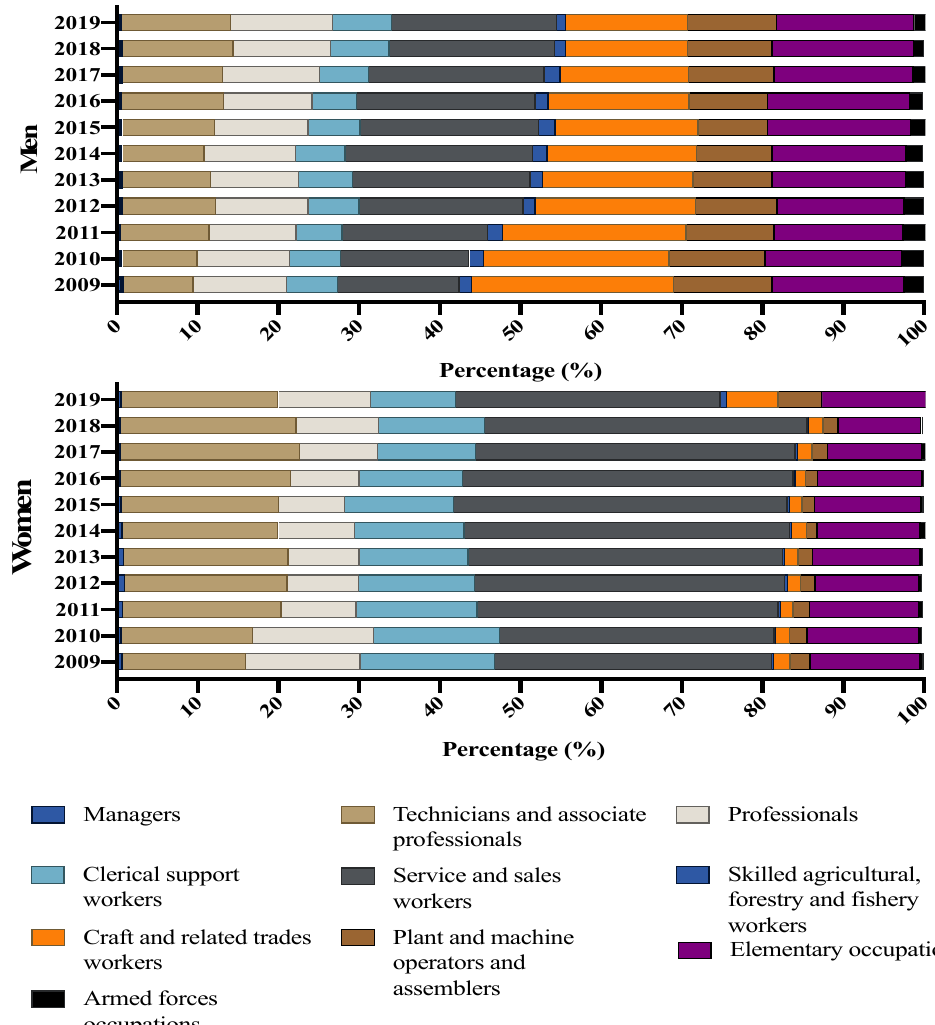
Figure 7. Employed people under 30 by gender and occupation, 2008–2019. Source: Eurostat. The pandemic that hit the world in 2020 caused the situation of dependency and insecurity for young people to worsen in the case of Spain. During the first semester of 2020, the number of contracts signed by people under 30 decreased more than those signed by the rest of the population. It is worth keeping in mind that this period included the economic standstill caused by the pandemic. According to PES data, temporary hiring of people under 30 between January and June 2020, in comparison to the same period in 2019, was reduced by 35.3% in the male population and 42.5% in the female population, and temporary hiring of people over 30 decreased by 30.3% and 39.9%, respectively. Regarding permanent hiring, the reduction in the same period was lower: 32% and 3.5% compared to 27.4% and 27.4%, respectively. Women under 30 lost the most contracts during this health crisis period, mainly in the service sector, one of the worst hit by the crisis. Figure 8 shows the evolution between 2019 and the second semester of 2020 of unemployment rates, temporary and part-time jobs, and NEET situations among people under 30, showing how, for both the female and the male populations, the rate of temporary jobs decreased